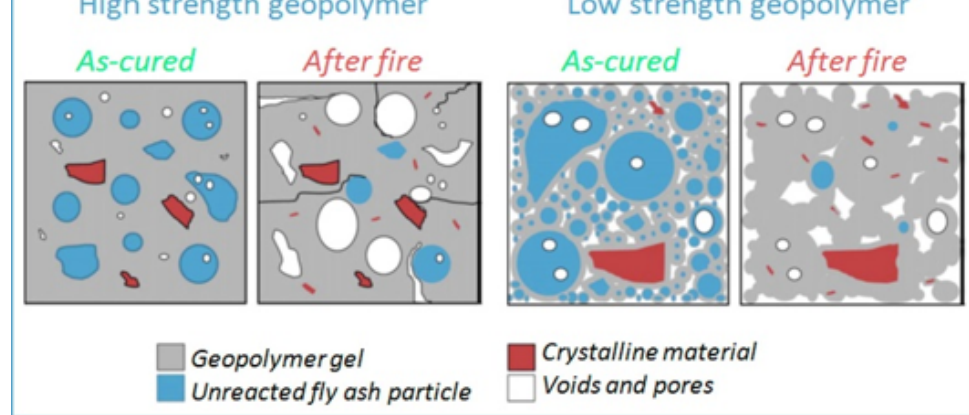
Figure 7: Schematic depiction of the proposed micro-structural changes in geopolymer paste upon firing [63]